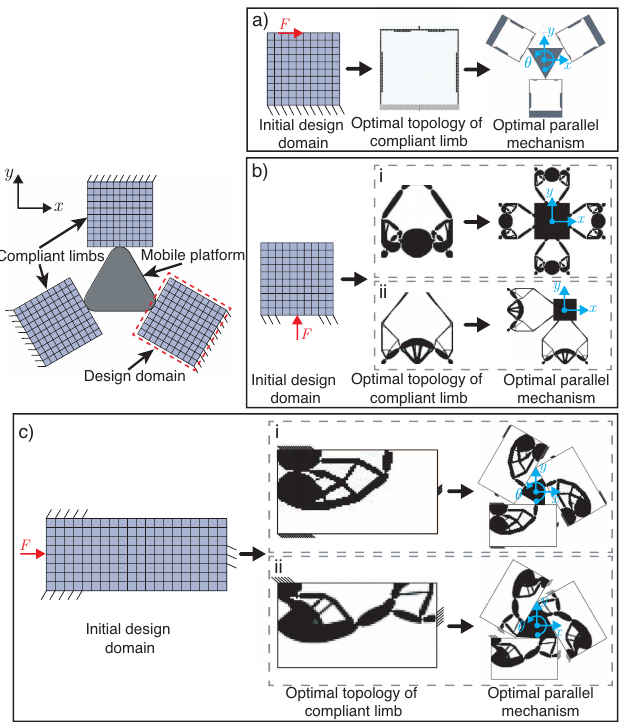
Figure 12. Schematic description of the Topology Optimization process to design the optimal com- pliant limbs of 2D compliant parallel mechanisms: ( a ) 3-DoF ( x , y , θ ) compliant parallel mechanism proposed by Lum et al. [200] (Adapted from [200] 2015, Elsevier); subfigures ( b , c ) are the 2-DoF ( x , y ) and the 3-DoF ( x , y , θ ) compliant parallel mechanisms, respectively, proposed by Jin et al. found in (i) [201] (Adapted from [201] 2016, Elsevier); and (ii) [202] (Adapted from [202] 2018,